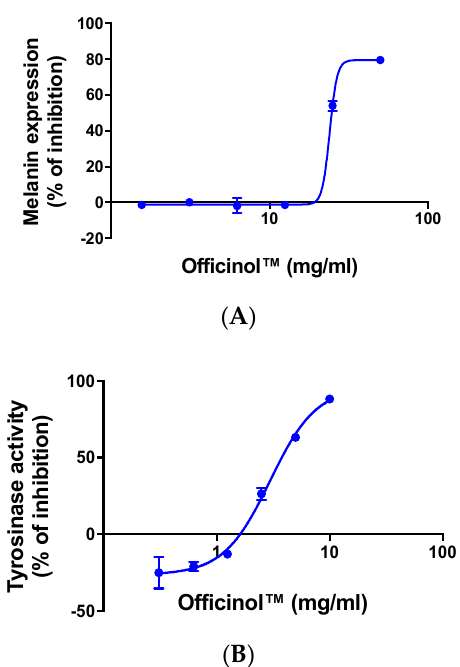
Figure 4. Officinol™ mitigates melanin pigmentation and tyrosinase activity. ( A ) Concentration-dependent inhibition effect of Officinol™ on melanin pigmentation in human melanocytes MNT-1 cells. Graph on a logarithmic scale. ( B ) Concentration-dependent inhibition effect of Officinol™ on enzymatic tyrosinase activity. Graph on a logarithmic scale. 3.5. O ffi cinol ™ Inhibits Elastase, a Cosmetic Target for Wrinkle Reduction